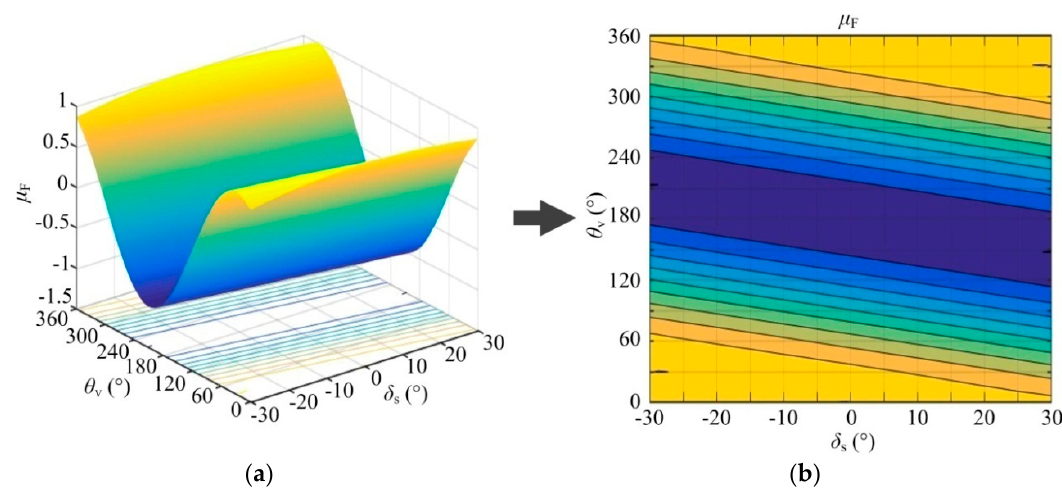
Figure 4. Flux active factor variation character. ( a ) three-dimensional image; ( b ) two-dimensional